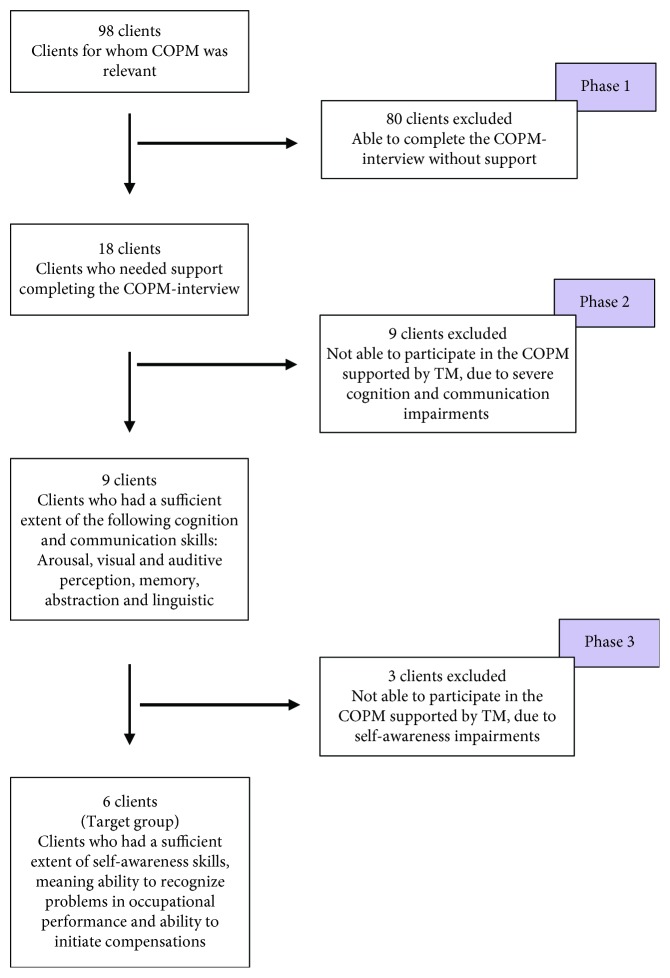
Client recruitment.